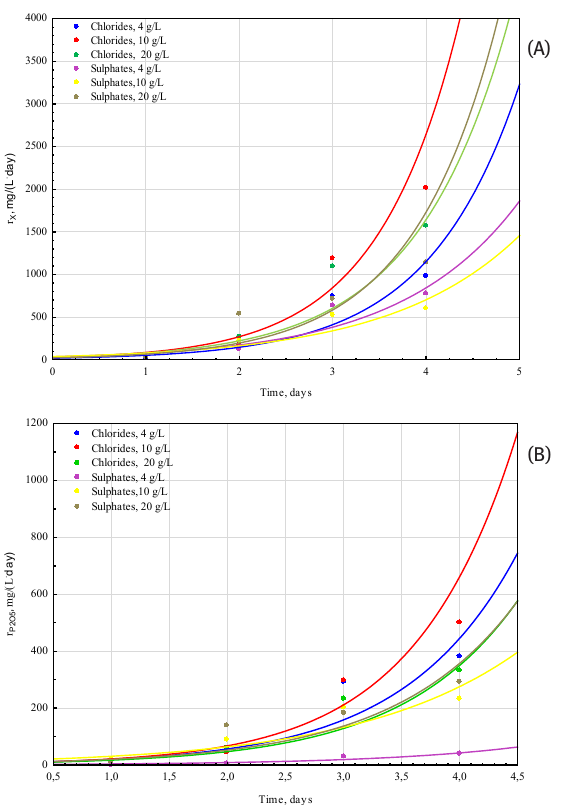
Table 5: Biomass yield coefficient of P